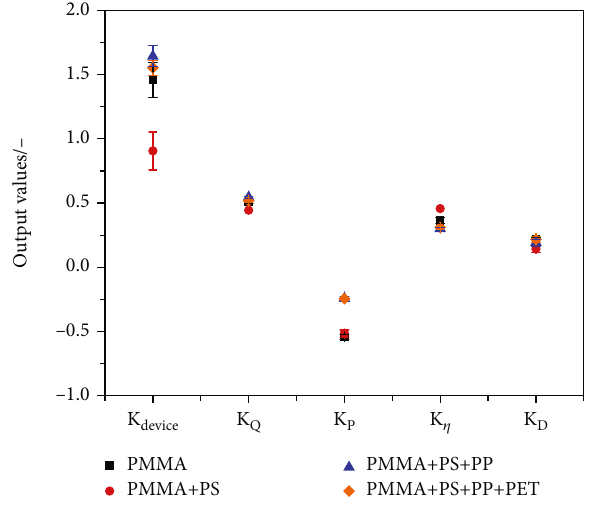
Figure 8: Parameters to predict the fi bre diameter attributing the power law dependence when melt spinning with the capillary rheometer combined with an